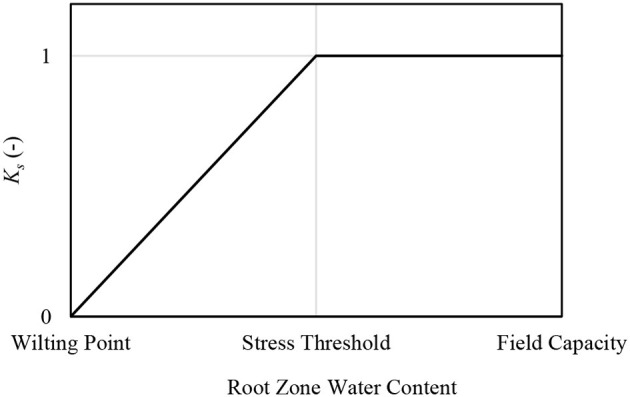
Generalized depiction of the piecewise water stress coefficient (Ks) function based on average root zone soil water content, as used in Allen et al. (1998) and Jensen and Allen (2016).